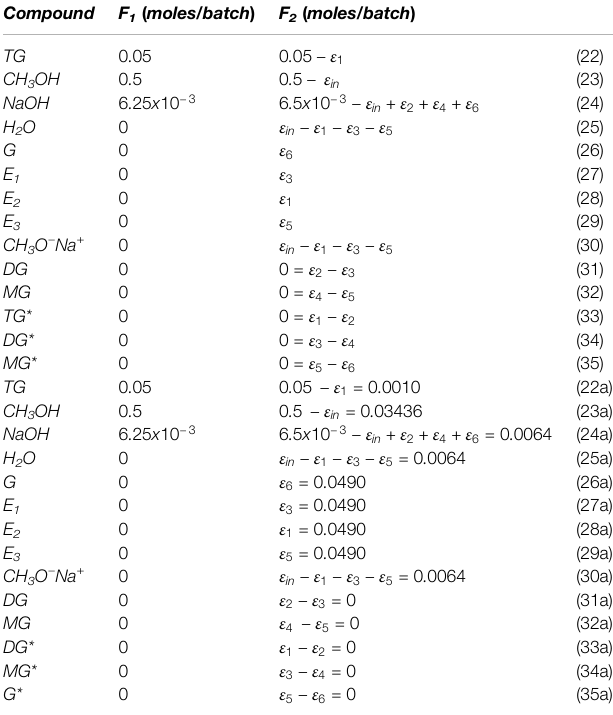
TABLE 5 | Solution of mass balances for experiment 9. Compound F 1 ( moles/batch ) F 2 ( moles/batch )